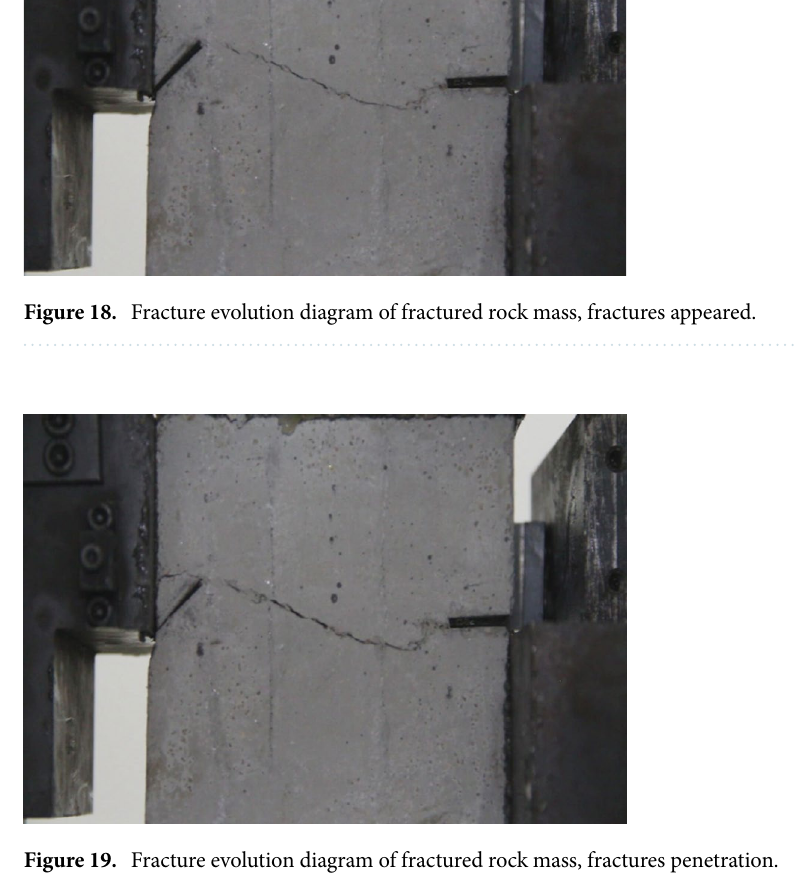
Figure 19. Fracture evolution diagram of fractured rock mass, fractures penetration.